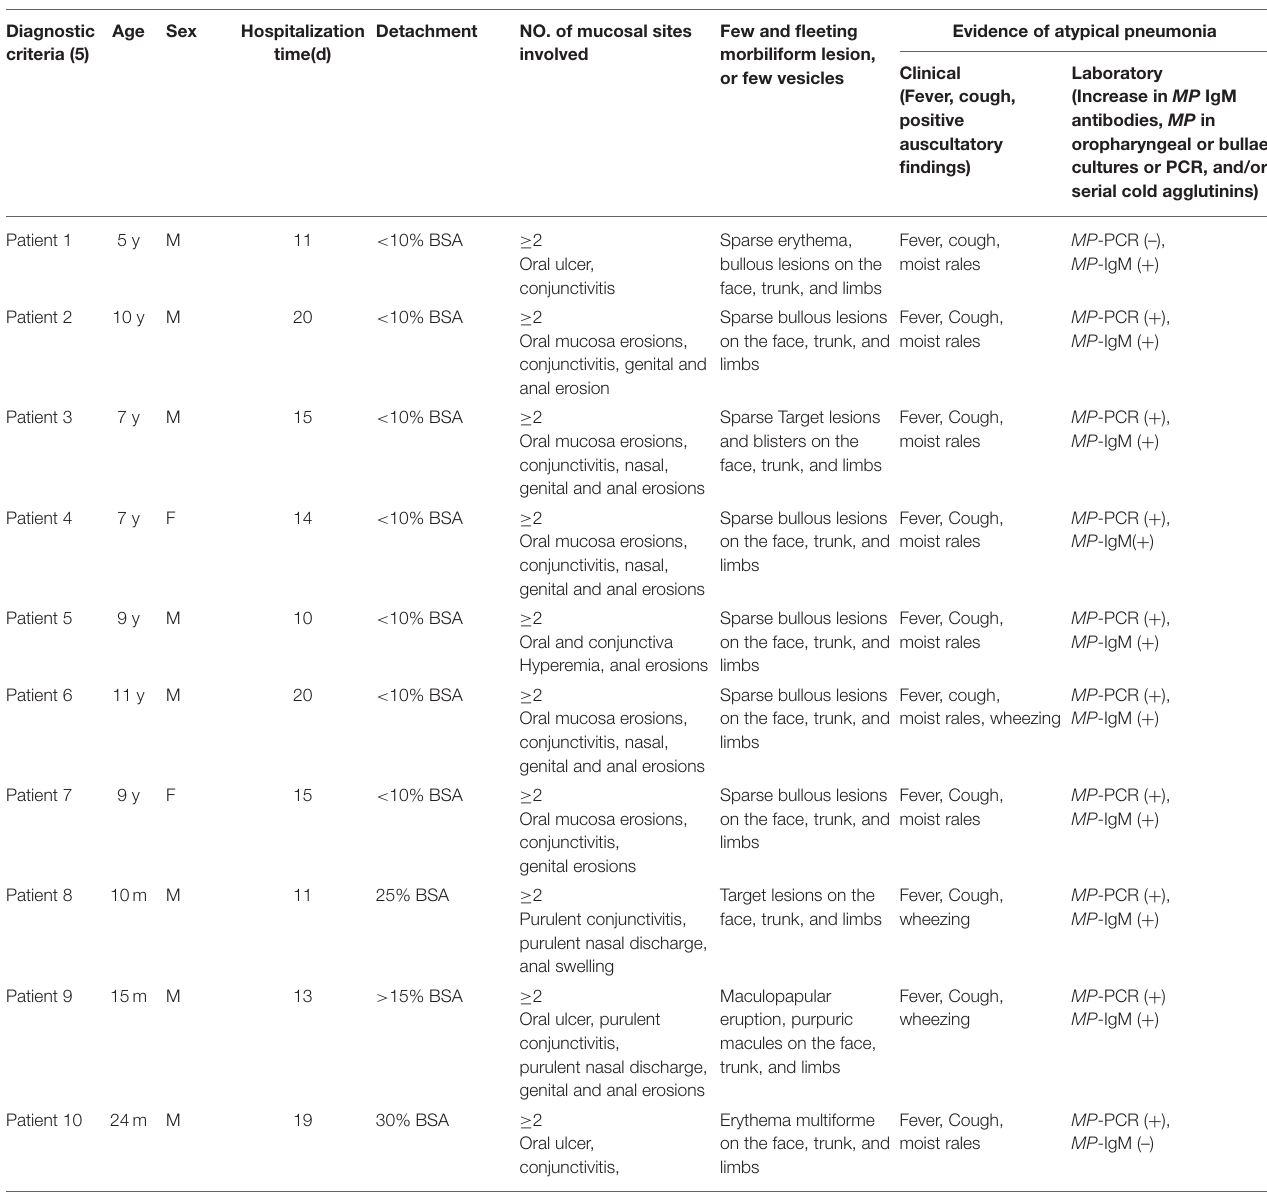
TABLE 1 | Case descriptions of 10 patients with MIRM. Diagnostic Age criteria (5)